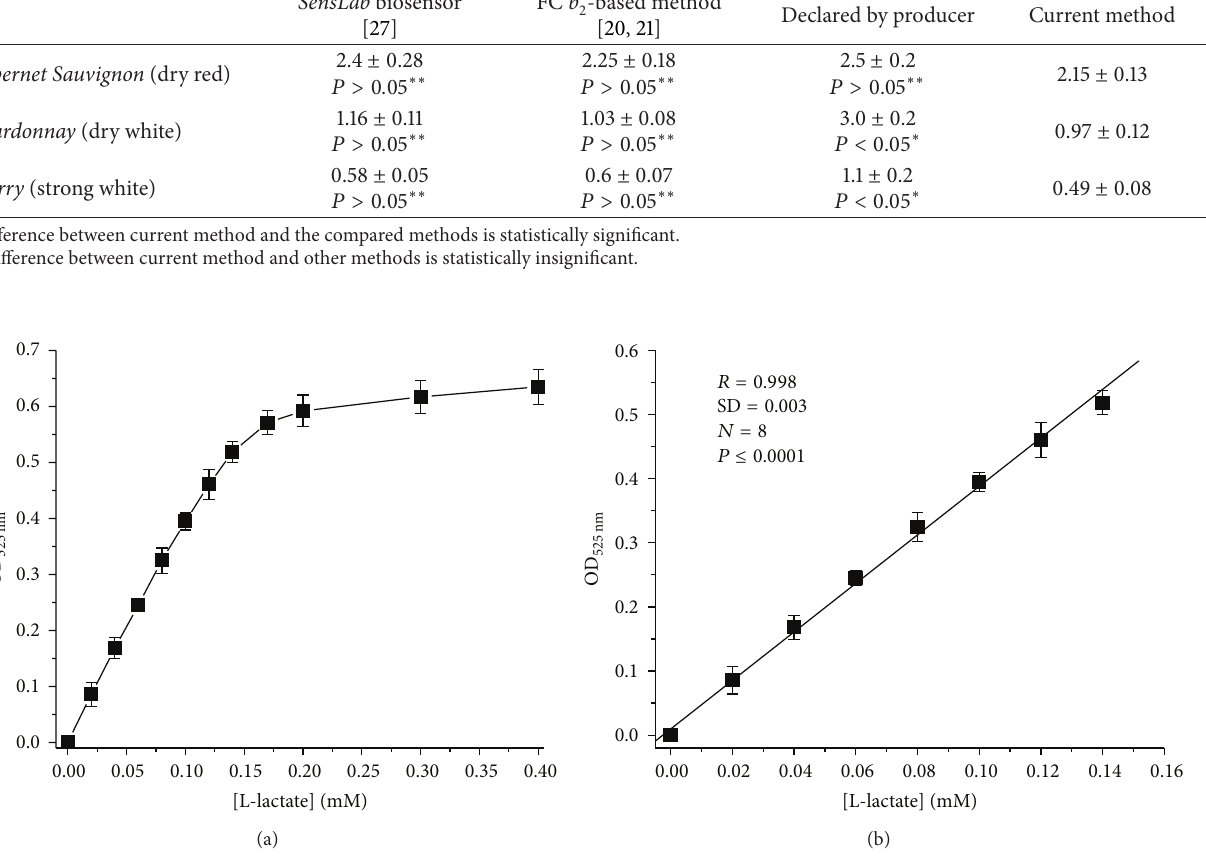
Figure 2: Dependence of optical density of the reaction mixture on L-lactate concentration (a) and a linear range (b) for enzymatic method. Conditions are described in Section